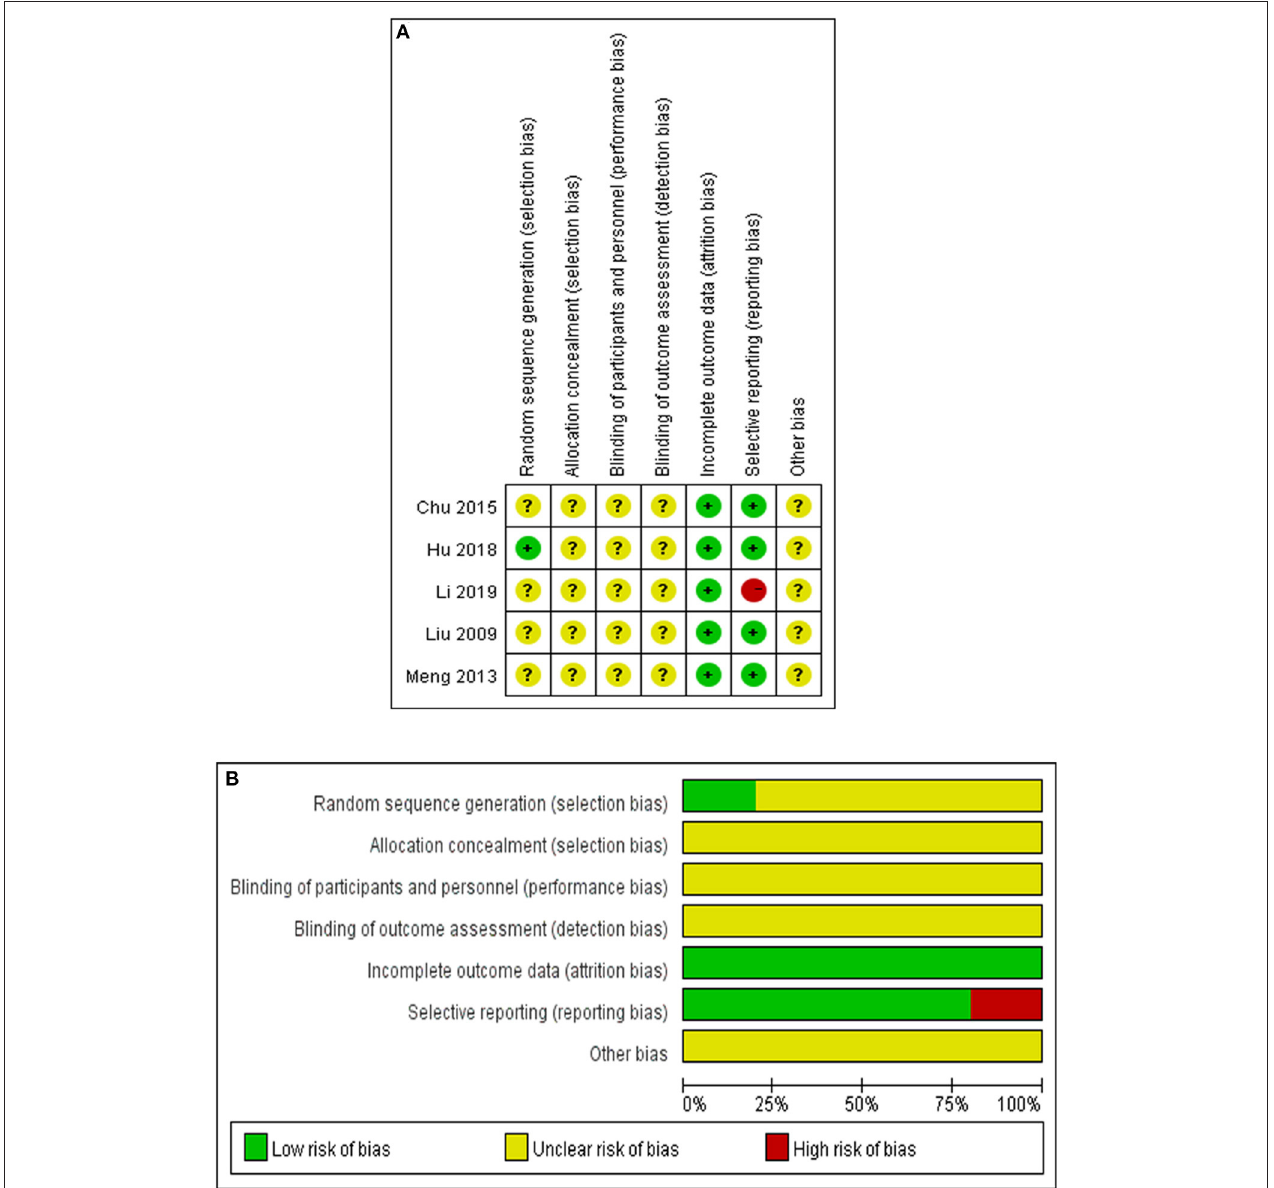
FIGURE 2 | Quality evaluation of the studies. (A) Summary of bias risk in each study. Evaluation of the bias risk was based on the reviewers’ assessments of seven items for each selected study as follows. “ + ” implies the existence of a low risk, “-” implies the existence of a high risk, “?” implies unclear risk bias because of a lack of relevant information. (B) Summary of bias risk in each item. Evaluation of the bias risk for each item was based on reviewers’ assessments of five studies for each bias risk item and are presented as percentages. studies (Chi 2 = 2.93, P = 0.57, I 2 = 0%). Therefore, a fixed effect model as well as RR values were selected for outcome analysis. The evidence of the meta-analysis revealed that the HUTT negative changing rate in the intervention group was remarkably higher than that in the control group (RR: